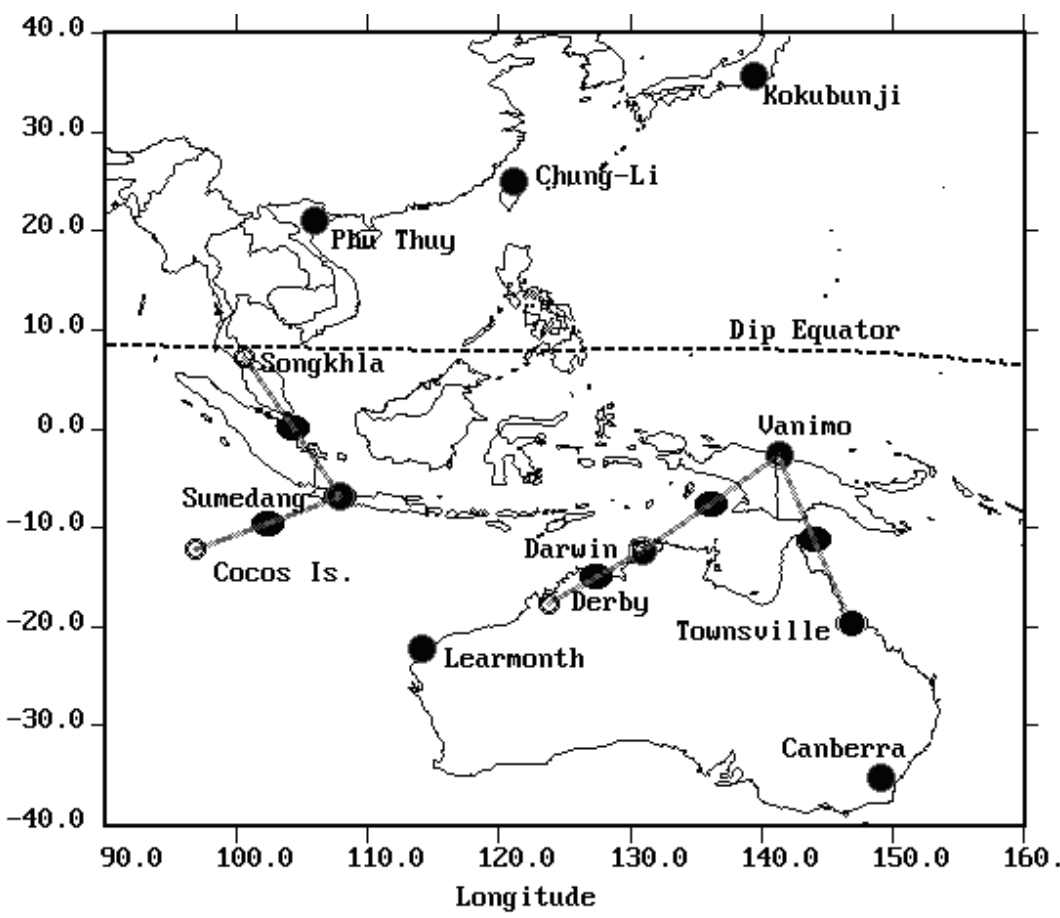
Fig. 1. The location of ionosonde sites and reflection points (filled circle) relative to the magnetic dip